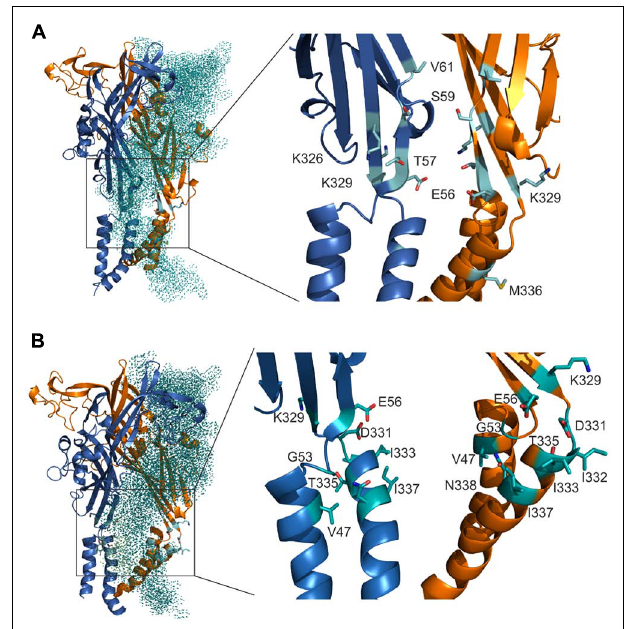
FIGURE 6 | Orientation of the side chain of residues are important for interaction with ions during gating. The positions of cadmium-affected residues are in closed (A) and open (B) states. In the left panels, the teal colored dotted subunit was removed for better visibility of the vestibule interior. Cadmium-affected residues in rP2X4R the homology model in closed and open states are presented in the right panels. Particular cadmium hits are presented as light blue sticks on light blue ribbon segments, and different subunits are presented in orange and dark